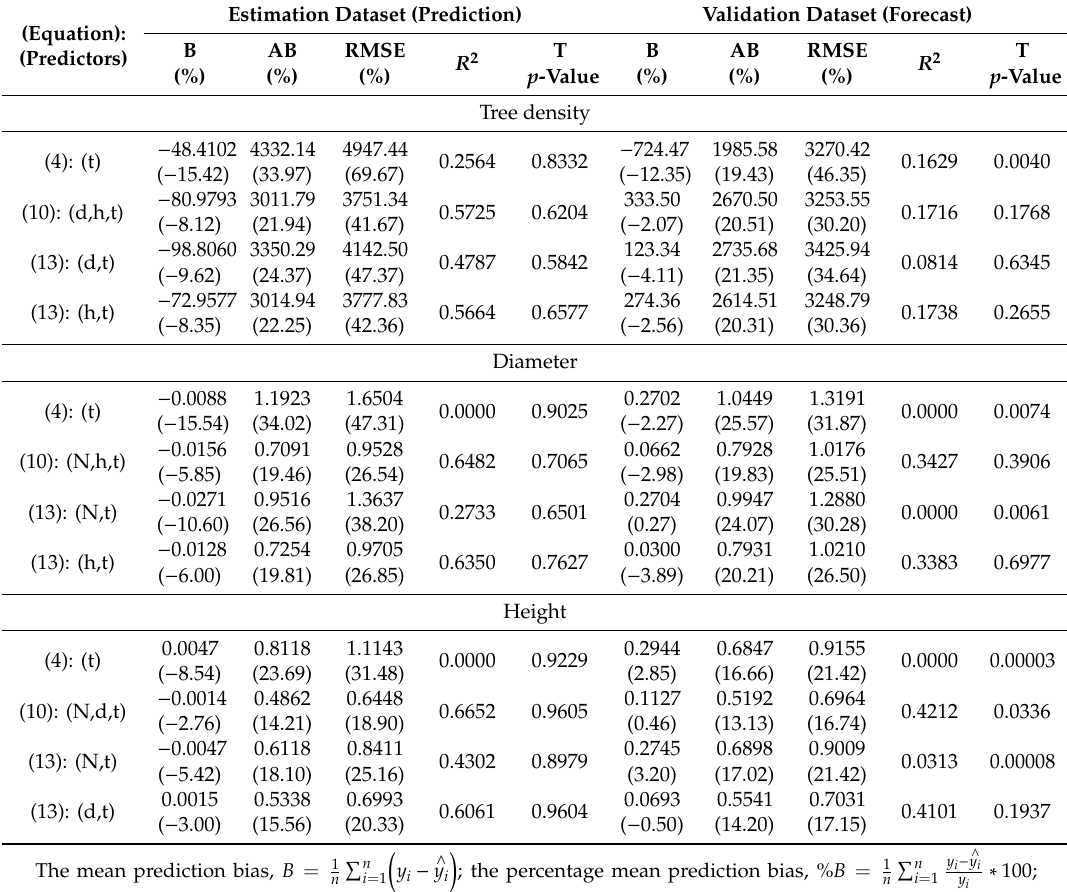
Table 13. Statistical measures and p -values of the Student’s t -test for the fixed-e ff ect scenario